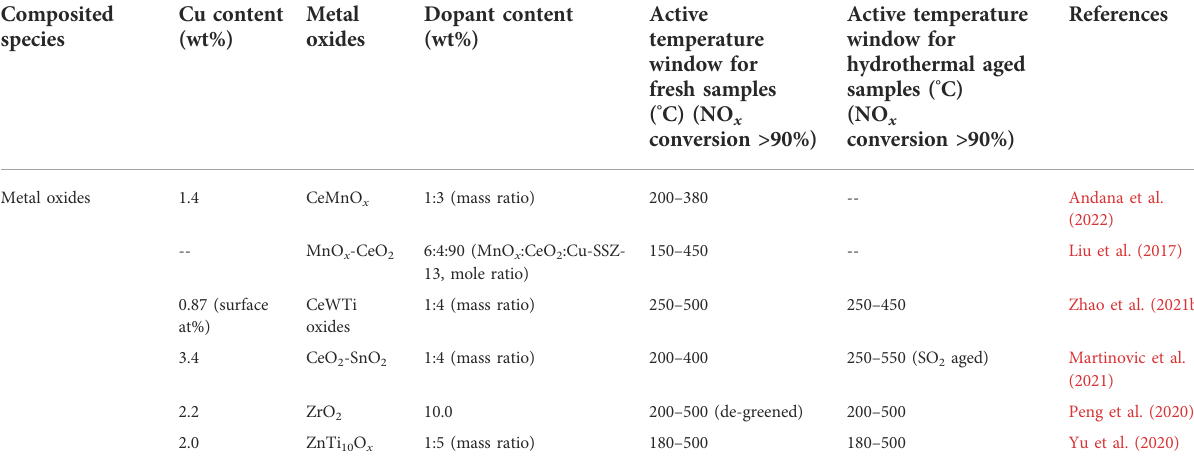
TABLE 4 Summary of the Cu-SSZ-13 catalysts composited with metal oxides. Composited